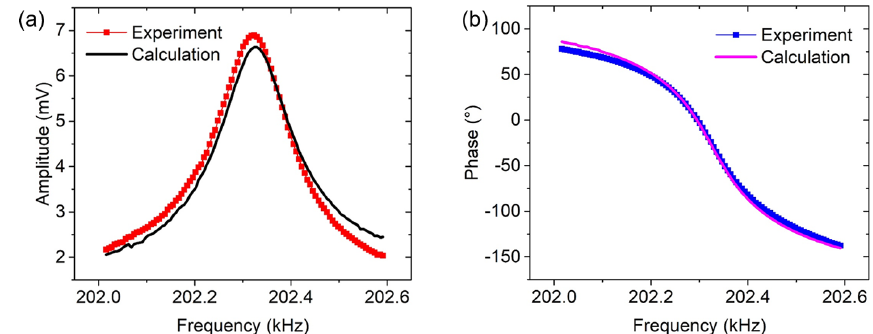
Figure 9. Measured and calculated graphs for (a) amplitude and (b) phase response of differential output signals.